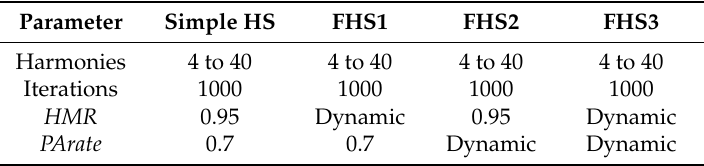
Table 1. Parameters for each of the methods.